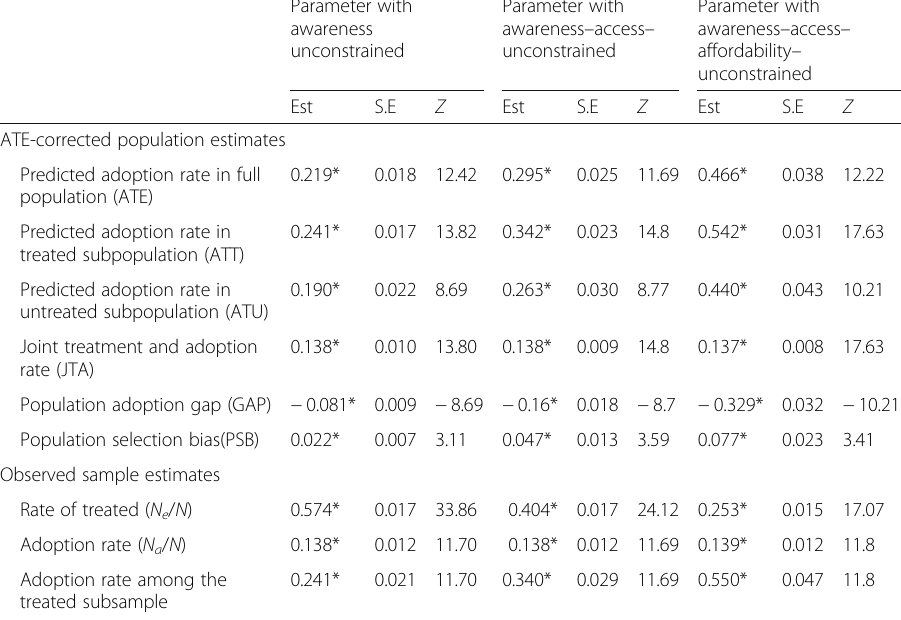
Table 4 Predicted DTMVs adoption rates